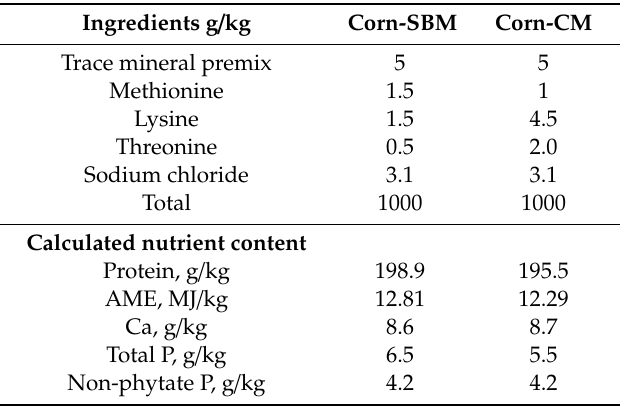
Table 2. Description of experimental diets and the analyzed crude protein content of the diets. Diet